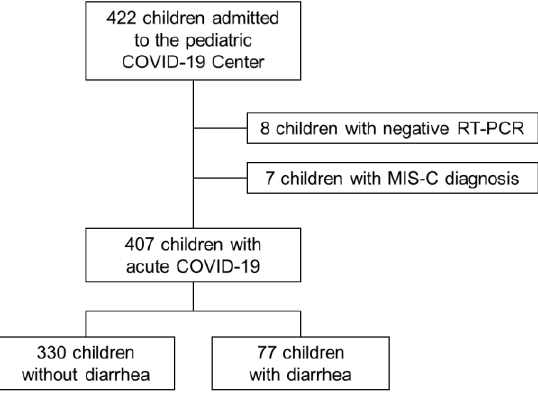
Figure 1. Flow diagram of study population.